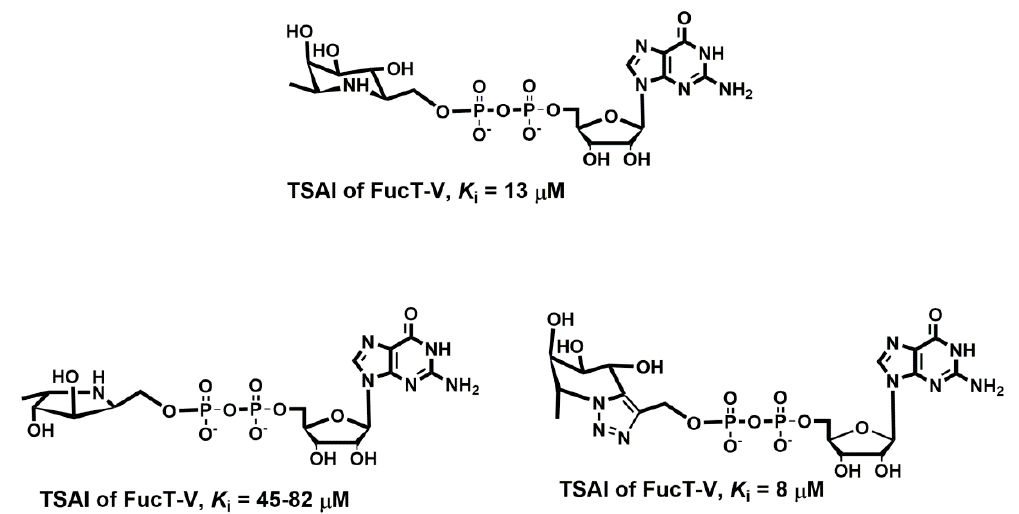
Figure 22. Schematic representation of selected transition state analog inhibitors. Molecules 2020 , 25 , x FOR PEER REVIEW